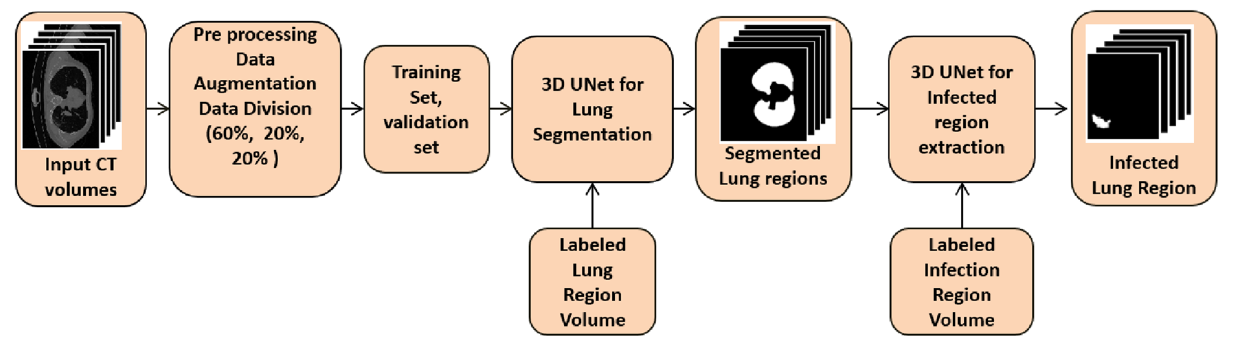
Figure 3. Overview of the proposed system